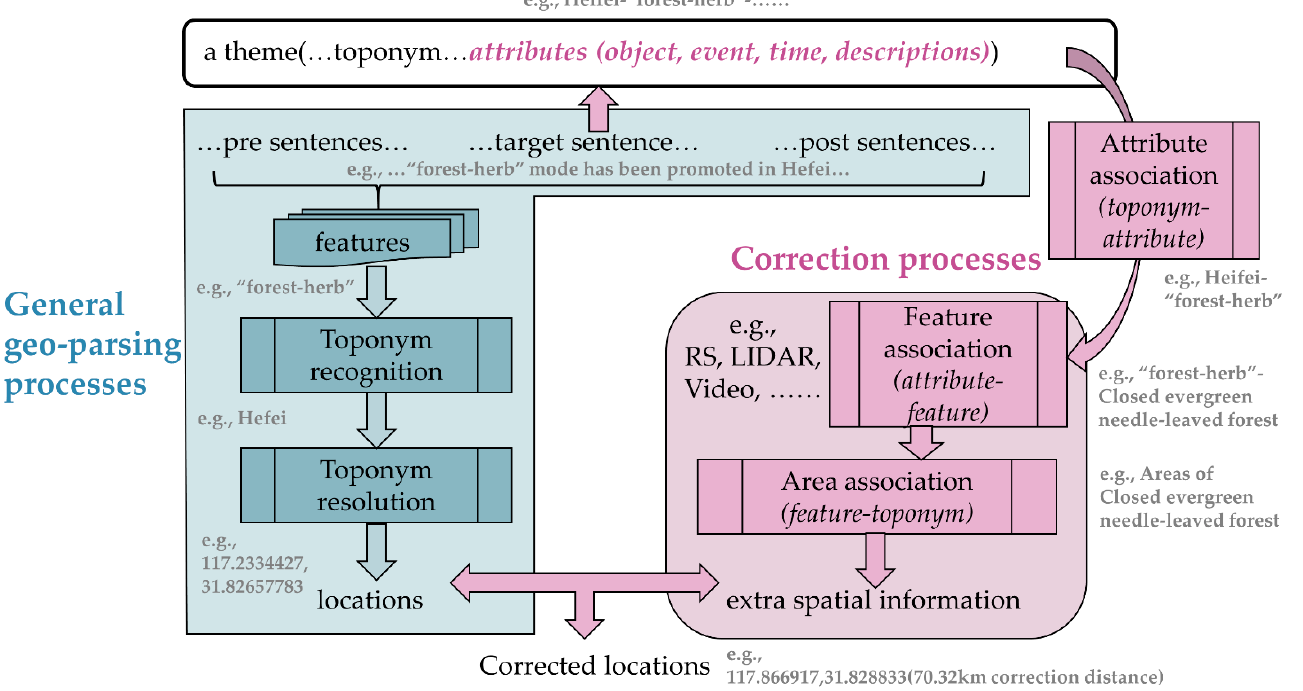
Figure 2. The basic idea of toponym correction based on remote sensing images. An example, “forest-herb” mode in Hefei is attached to show the results of each process. The detailed data and validation of this example can be found in Section 4 with the id 5 forest ecological pattern.